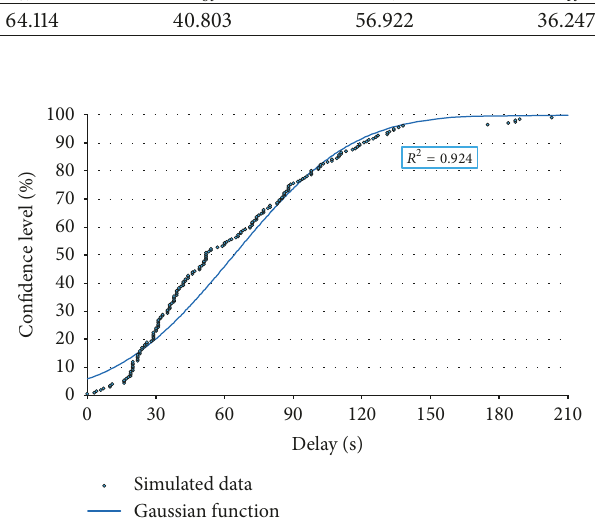
Figure 5: Comparison between cumulative distributions in the case of the outward trip.